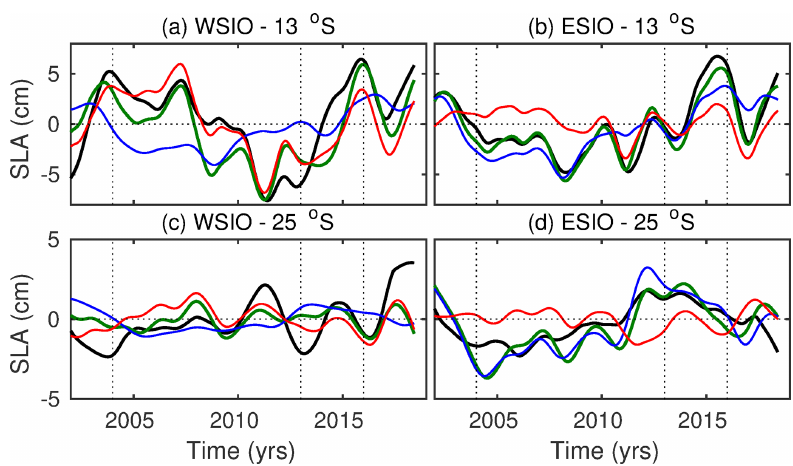
Figure 11. Time series of the simulated ECCO LLC270 SLA from the ITF-off simulation (black curves) and RG-modeled SLA using the eastern boundary forcing (blue curves), the local wind stress curl forcing (red curves), and both forcing terms (green curves), averaged between (a, c) 55–90 ◦ E and (b, d) 90–110 ◦ E at 13 ◦ S (a, b) and 25 ◦ S (c, d) . Vertical dashed lines indicate the years 2004, 2013, and